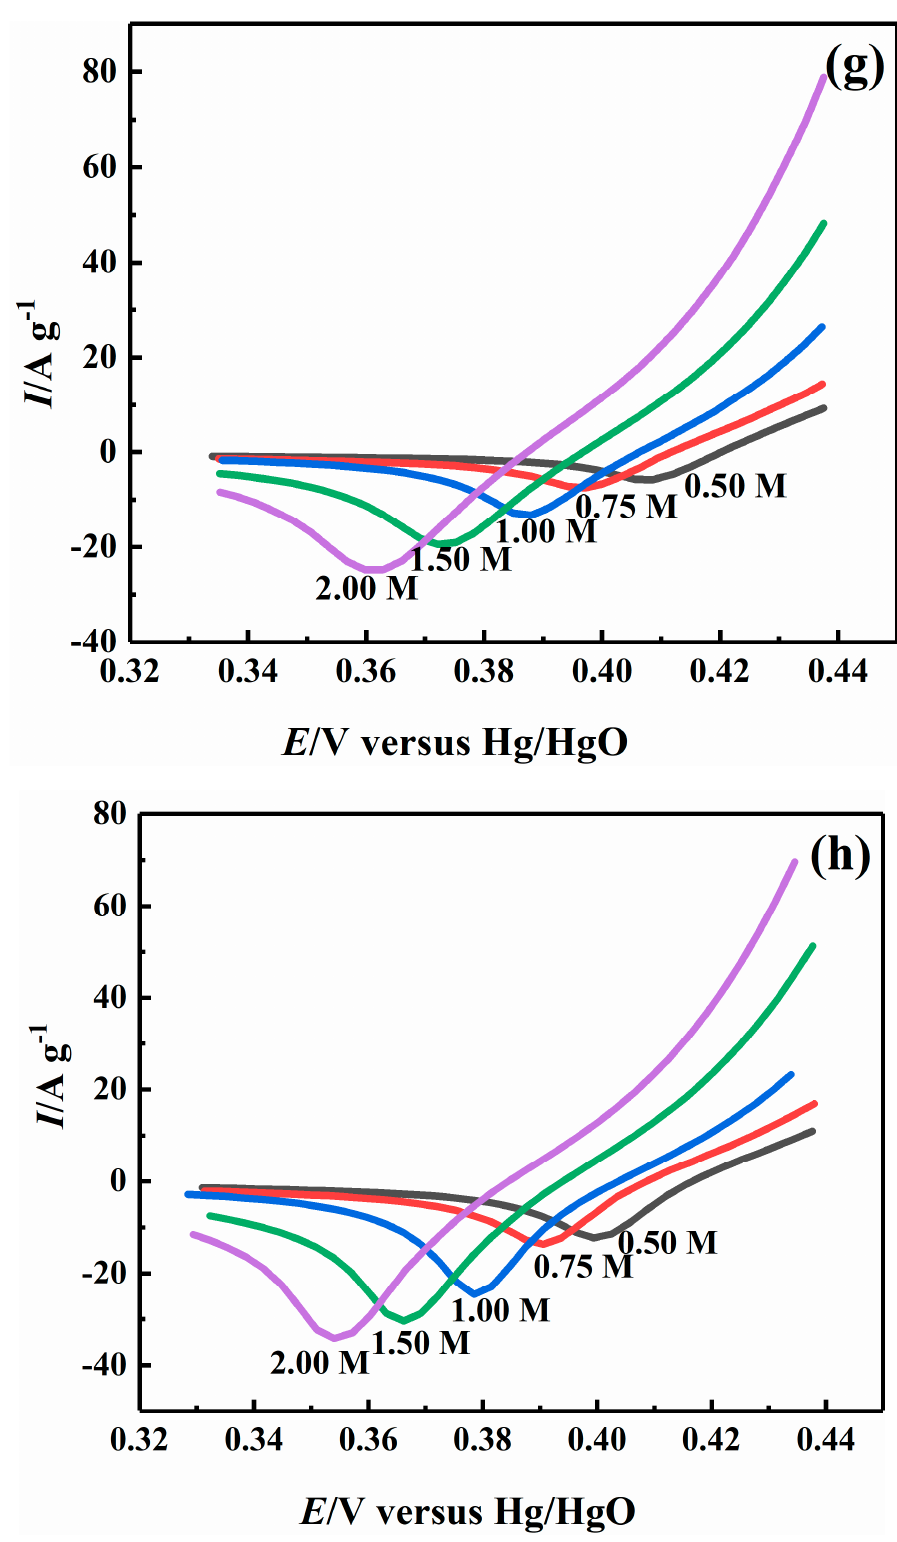
Figure 5. Cyclic voltammograms of the methanol oxidation on Ni-B ( a ), Ni-B-Co 0.02 ( b ), Ni-B-Co 0.05 ( c ), and Ni-B-Co 0.1 ( d ) nanoparticles at potentials ranging from 0 to 0.85 V in (0.5–2.0 M) NaOH + 1 M CH 3 OH solutions at a scan rate of 10 mV s − 1 . Insets: Double logarithmic plots of the anodic peak currents for methanol oxidation versus hydroxide ion concentrations. The reduction peak curves of NiOOH to Ni(OH) 2 are also shown for Ni-B ( e ), Ni-B-Co 0.02 ( f ), Ni-B-Co 0.05 ( g ), and Ni-B-Co 0.1 ( h ) nanoparticles. The reduction peaks of NiOOH to Ni(OH) 2 were not observed when the NaOH concentrations were relatively low at 0.5 and 0.75 M for the Ni-B nanoparticles, but the reduction peak currents